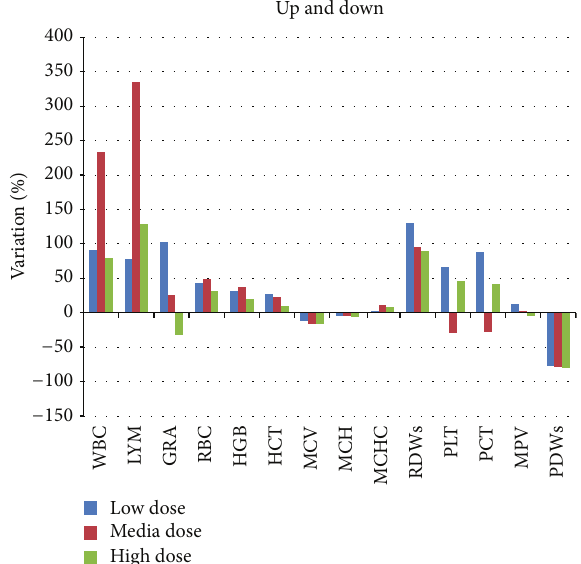
Figure 10: Results of the chemical-clinical analysis in the Up and Figure 9: Hematological parameters considered for the evaluation Down CD-1 treated mice: the percentage of variation of every of possible effects after the observation period. The data are shown parameter for each concentration used compared to the control as percentage of variation and were compared to the same values of is reported. CRE: creatinine; ALB: albumin; BUN: blood urea the negative control. nitrogen; TBIL: total bilirubin; TPR: total protein; ALT: alanine transaminase; and AST: aspartate transaminase. Table 3: Weight of the Peyer’s patch from the treated mice; data are averages of each group of treatment (divided for concentration used) plus the negative control group. In each average, the male and females weights are included. Control Low dose Media dose High dose Peyer’s patch (g) 8,25 10,17 9,33 8,50